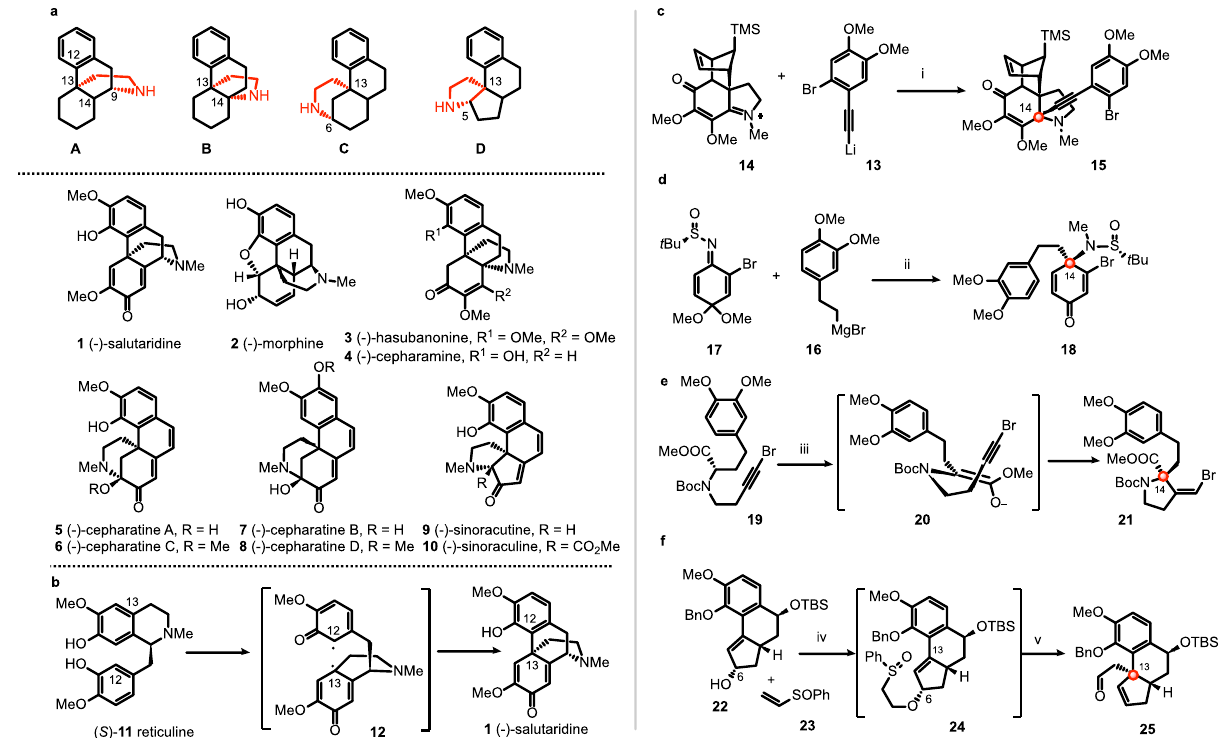
Fig. 1 Hasubanan alkaloids and reported asymmetric syntheses. a Representative skeletons of morphinan ( A ) and hasubanan alkaloids ( B , C , and D ); b biosynthesis of morphinan and hasubanan alkaloids; c Herzon ’ s synthesis: construction of α -tertiary amine by diastereoselective nucleophilic addition of arylacetylide to chiral iminium salt; d Reisman ’ s synthesis: construction of α -tertiary amine by diastereoselective addition of Grignard reagent to chiral N - tert -butanesul fi nimine; e Kim ’ s synthesis: construction of α -tertiary amine from α -amino ester via the memory of chirality approach; f Trauner ’ s synthesis: construction of quaternary carbon stereocenter by stereoselective [3,3]-sigmatropic rearrangement. Reagents and conditions: (i) − 90 °C, 62%; (ii) THF, − 78 °C, then MeI, HMPA, then aq. AcOH, 77%, d.r. 96:4; (iii) KO t Bu, DMF, 0 °C, 79%; (iv) NaH, THF, then KH, 0 °C to rt; (v) NaHCO dichlorobenzene, 176 °C, 57% over 2 steps. HMPA hexamethylphosphoramide, DMF N,N -dimethylformamide, THF tetrahydrofuran.